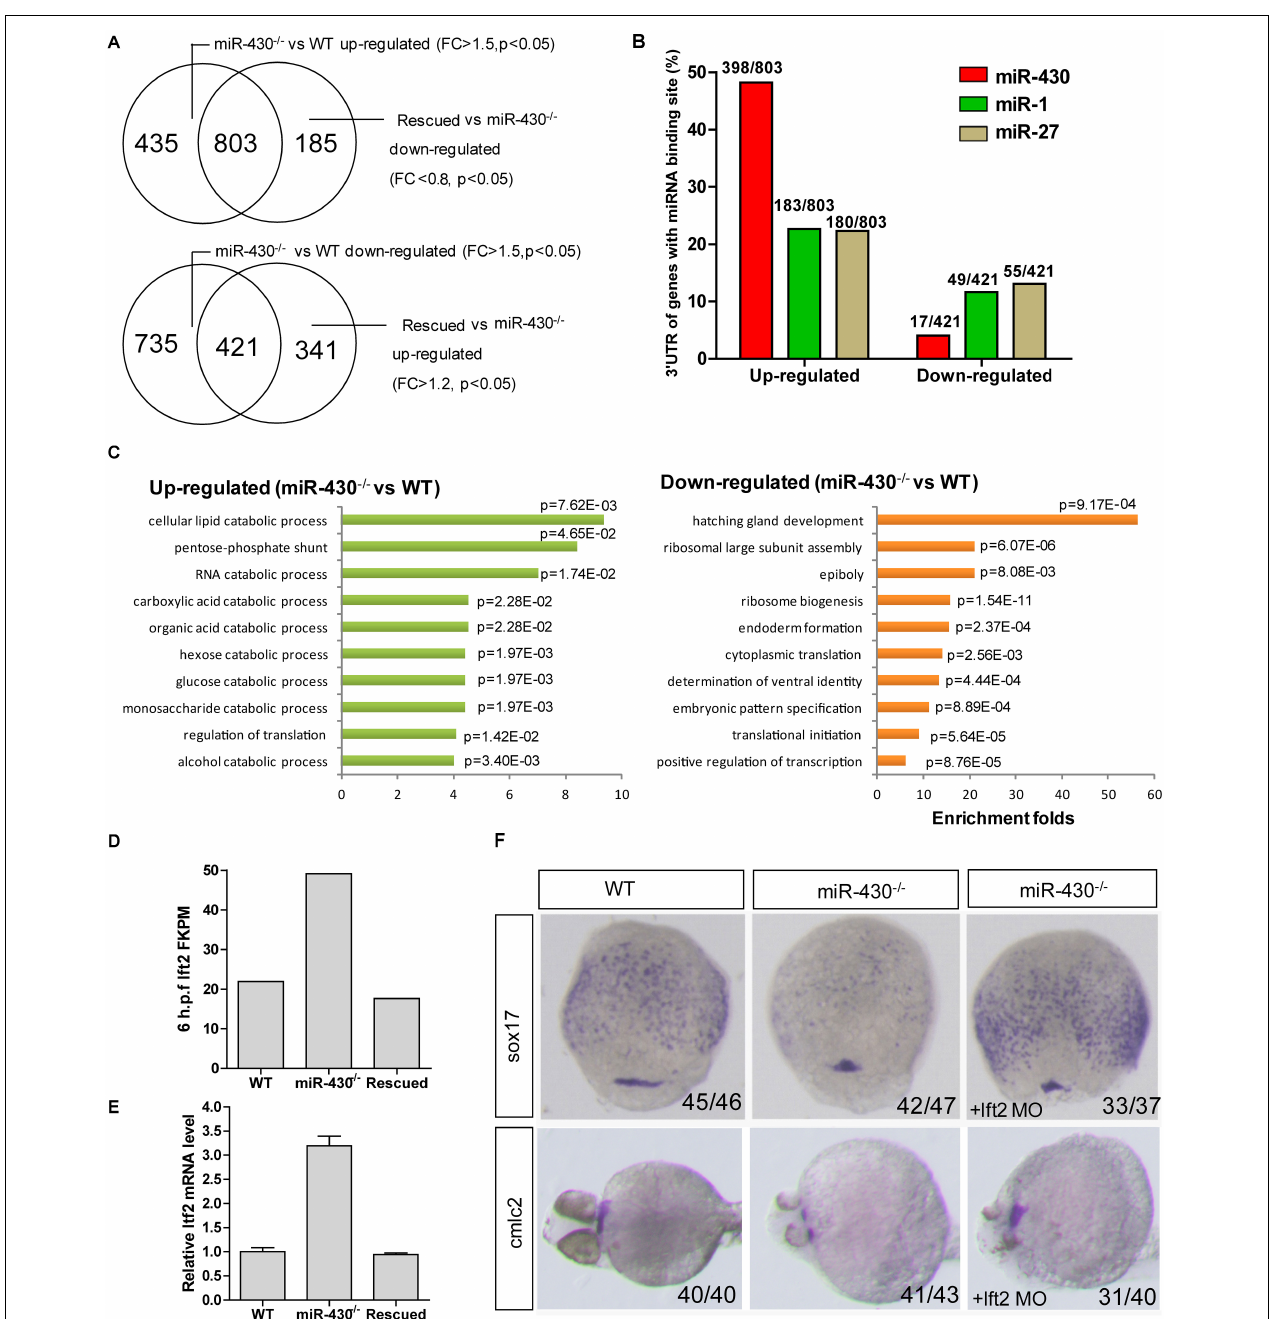
FIGURE 4 | Transcriptome analysis. Total mRNAs of embryos from WT, miR-430 − / − mutant and rescued groups were collected at shield stage for transcriptome sequencing. (A) Identification of miR-430 -regulated genes. (B) MiR-430 binding site analysis. The ratios indicate the numbers of genes with canonical sites of the indicated miRNA in their 3 (cid:48) UTR/total number of analyzed genes. The miRNA binding sites were predicted by TargetScanFish 6.2. (C) GO analysis of the miR-430 regulated genes, performed by the DAVID system. (D) The expression of lft2 in the transcriptome of the WT, miR-430 − / − and rescued embryos. (E) Q-PCR analysis of lft2 mRNA expression levels in the WT, miR-430 − / − and rescued group. Data are expressed as mean values ± S.E.M ( n = 4). (F) MO knockdown of lft2 partially rescued the miR-430 -deficient phenotypes. The embryos were collected at 75% epiboly and 36 hpf for WISH analysis of marker gene expression.